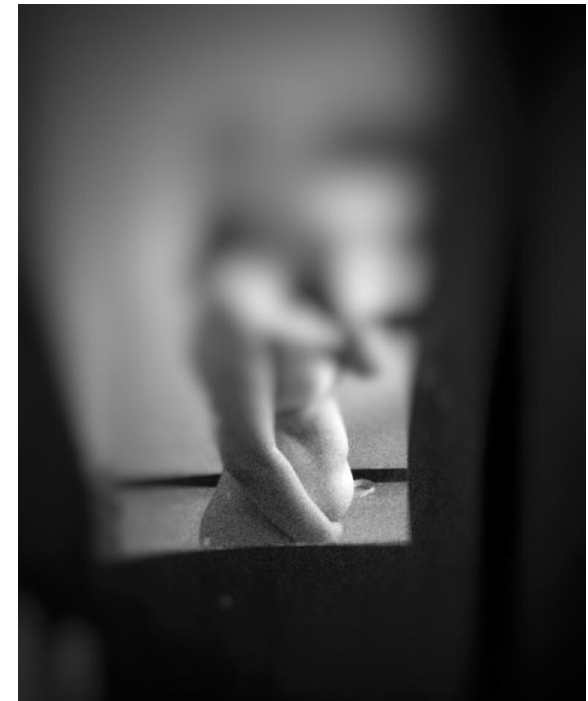
A Self-Portrait Portraying Decline in